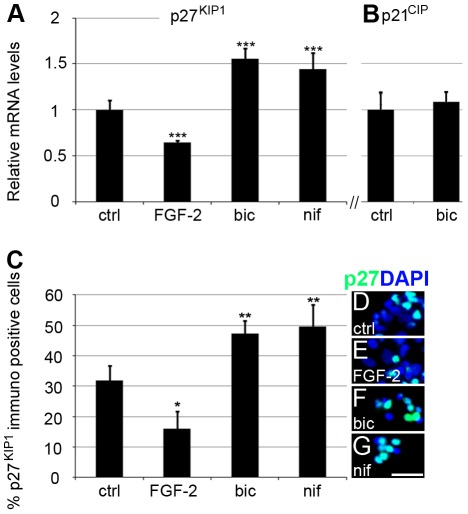
Expression of cyclin-dependent protein kinase inhibitors p27KIP1 and p21CIP in cultured NPE cells.mRNA levels in cultured NPE cells were analysed by qRT-PCR and normalised to β-actin and TATA box binding protein. Relative expression of (A) p27KIP1 in control (1 µM GABA), FGF-2- (1.5 µg/ml), bicuculline- (20 µM bicuculline, 1 µM GABA), or nifedipine-treated (10 µM nifedipine, 1 µM GABA) cells. (B) Relative mRNA levels of p21CIP in control (1 µM GABA) or bicuculline-treated cells (20 µM bicuculline, 1 µM GABA). Fixed dissociated cells were stained with the nuclear stain DAPI and an antibody against p27KIP1. (C) Percentage of p27KIP1 cells in the control, FGF-2-, bicuculline- and nifedipine-treated cells. Error bars ±SD, n = 4 independent cultures. Statistical test was one-way ANOVA, Tukey's multi-comparison post hoc test; p<0.05*, p<0.01**, p<0.001***. Representative images of p27KIP1 immunoreactivity among (D) control, (E) FGF-2, (F) bicuculline- or (G) nifedipine-treated cells. Scale bar in (G) is 25 µm and is also valid for (D)–(F). bic, bicuculline; ctrl, control; FGF-2, basic fibroblast growth factor; nif, nifedipine.